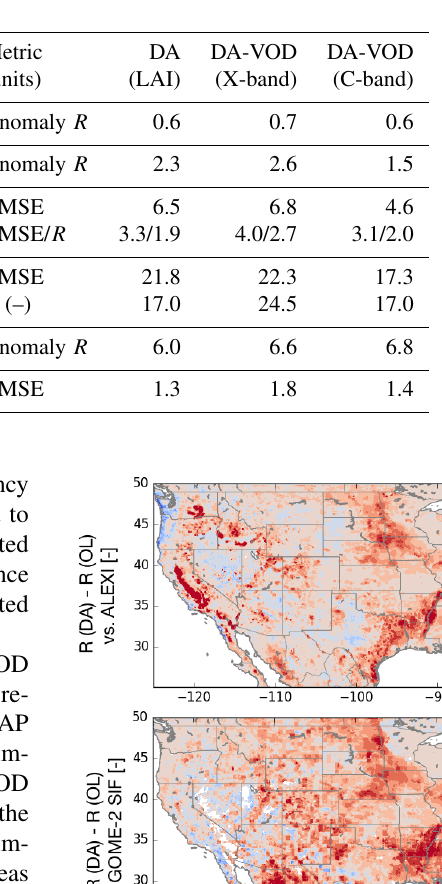
Table 1. Comparison of the percentage improvements in domain-averaged skill metrics (relative to the model OL) for DA configurations that assimilate MODIS LAI (from Kumar et al., 2019b) and those that employ X- and C-band VOD retrievals, for different variables. SFSM – surface soil moisture, RZSM – root zone soil moisture, ET – evapotranspiration, GPP – gross primary productivity, TWS – terrestrial water storage, SF – streamflow.